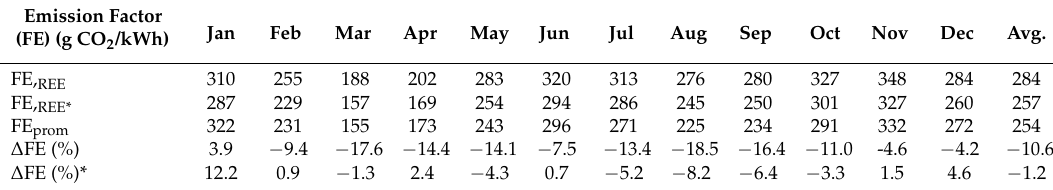
Table 13. Details of the emission factor in the Spanish electricity mix.